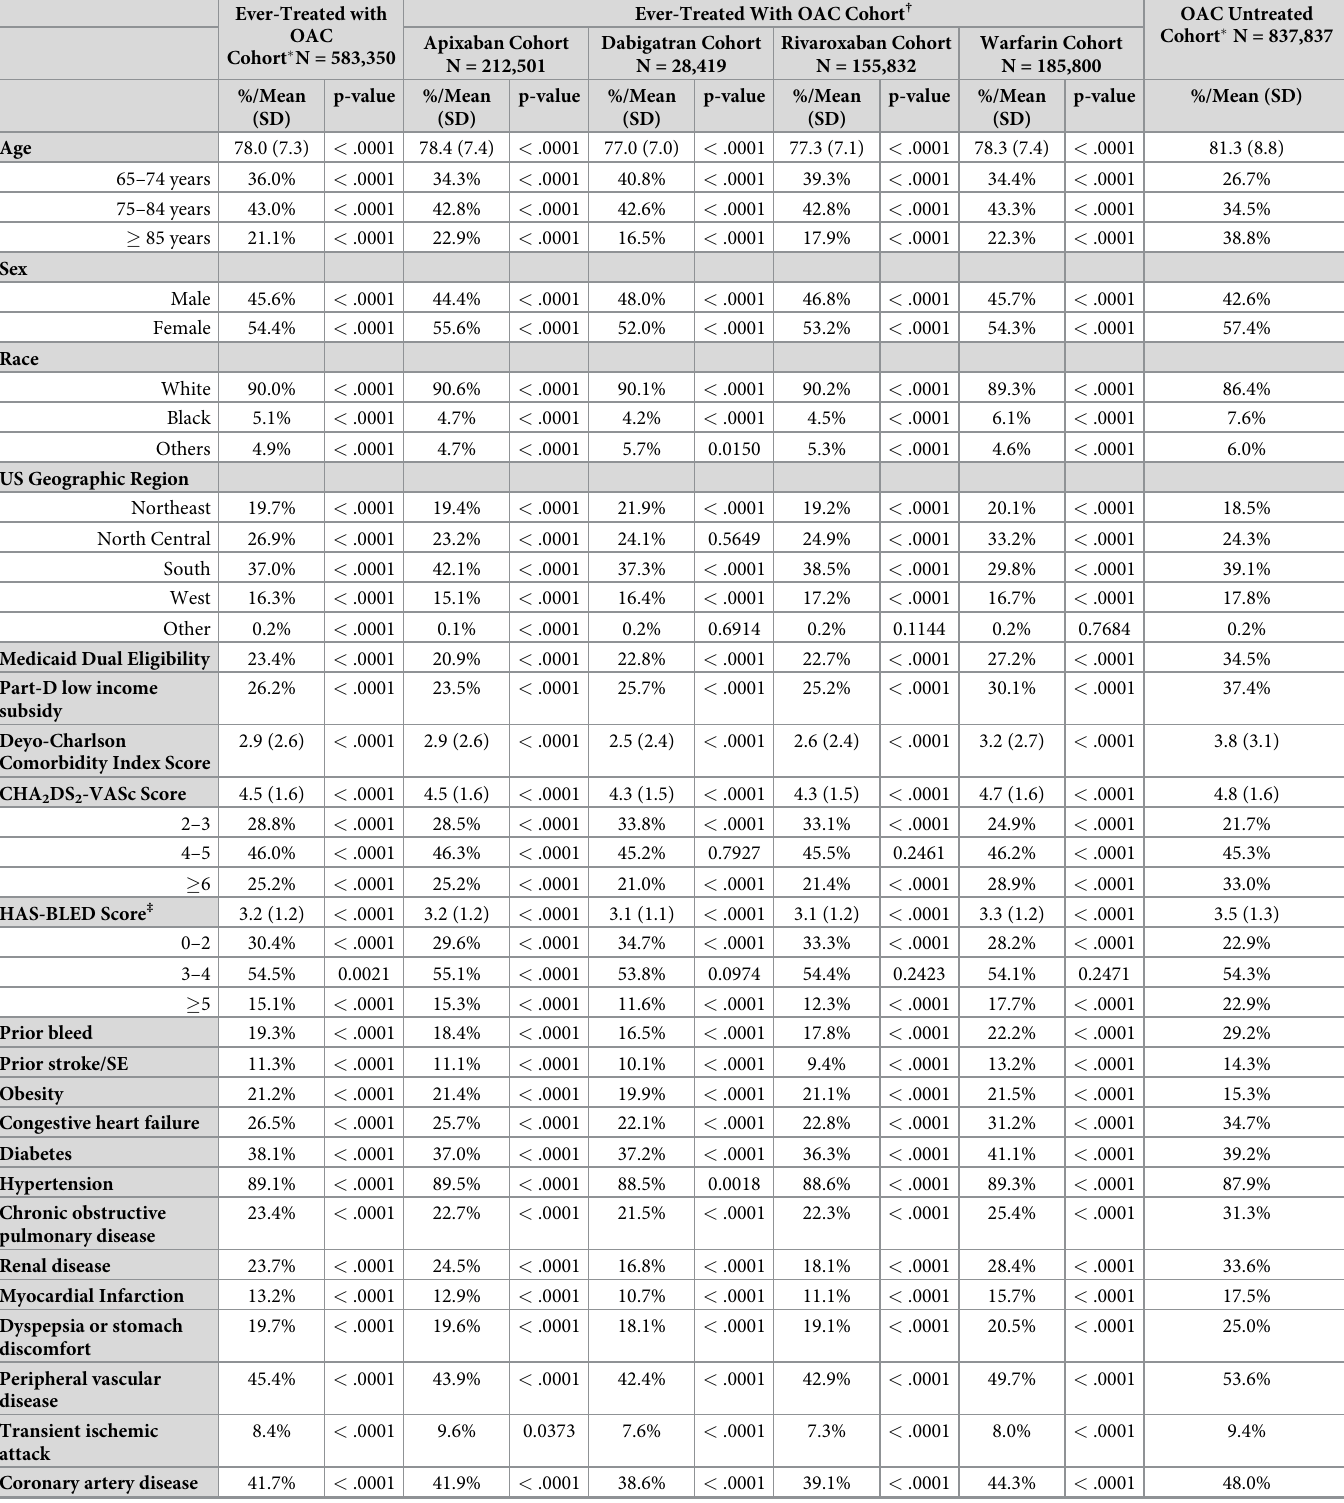
Table 1. Baseline descriptive results for ever-treated and OAC untreated with OAC